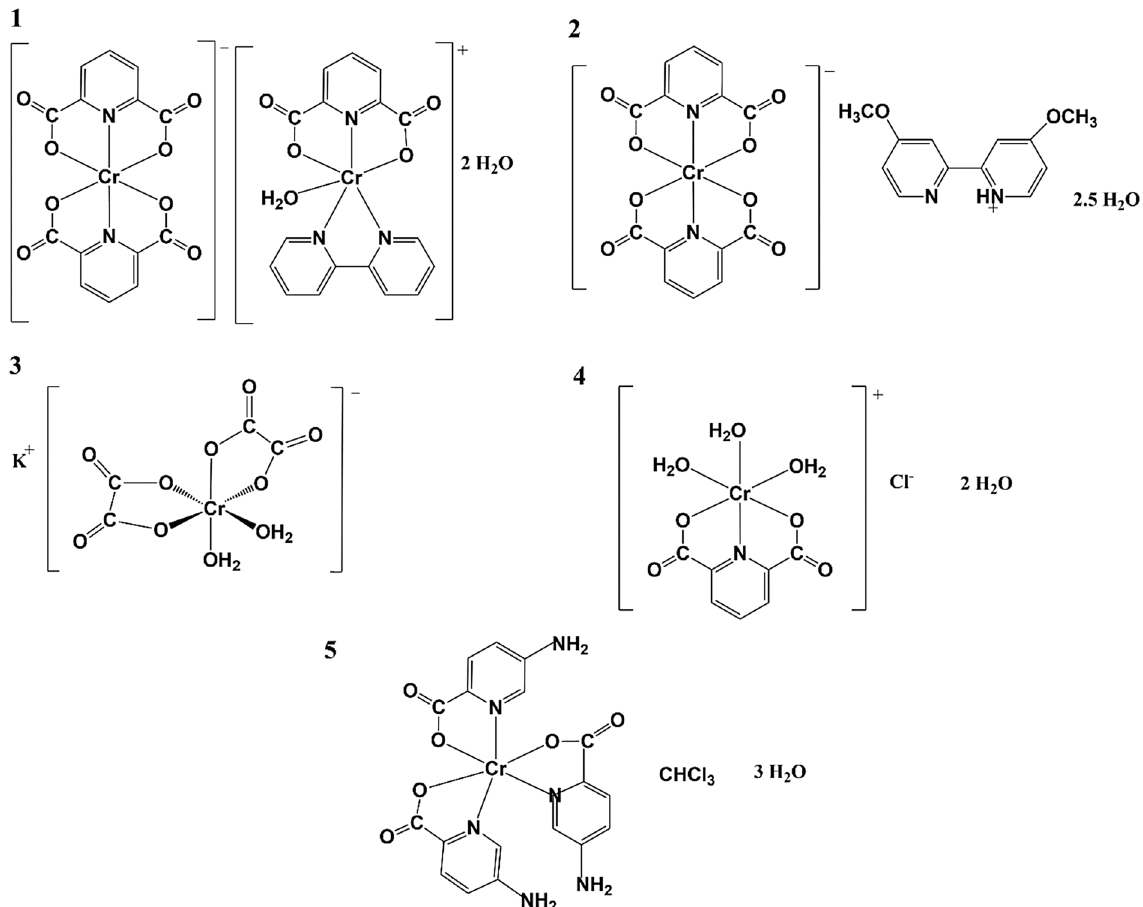
Figure 1. The structures of complex compounds acting as catalysts in ethylene oligomerization: (1) [Cr(dipic) 2 ] [Cr(bipy)(dipic)(H